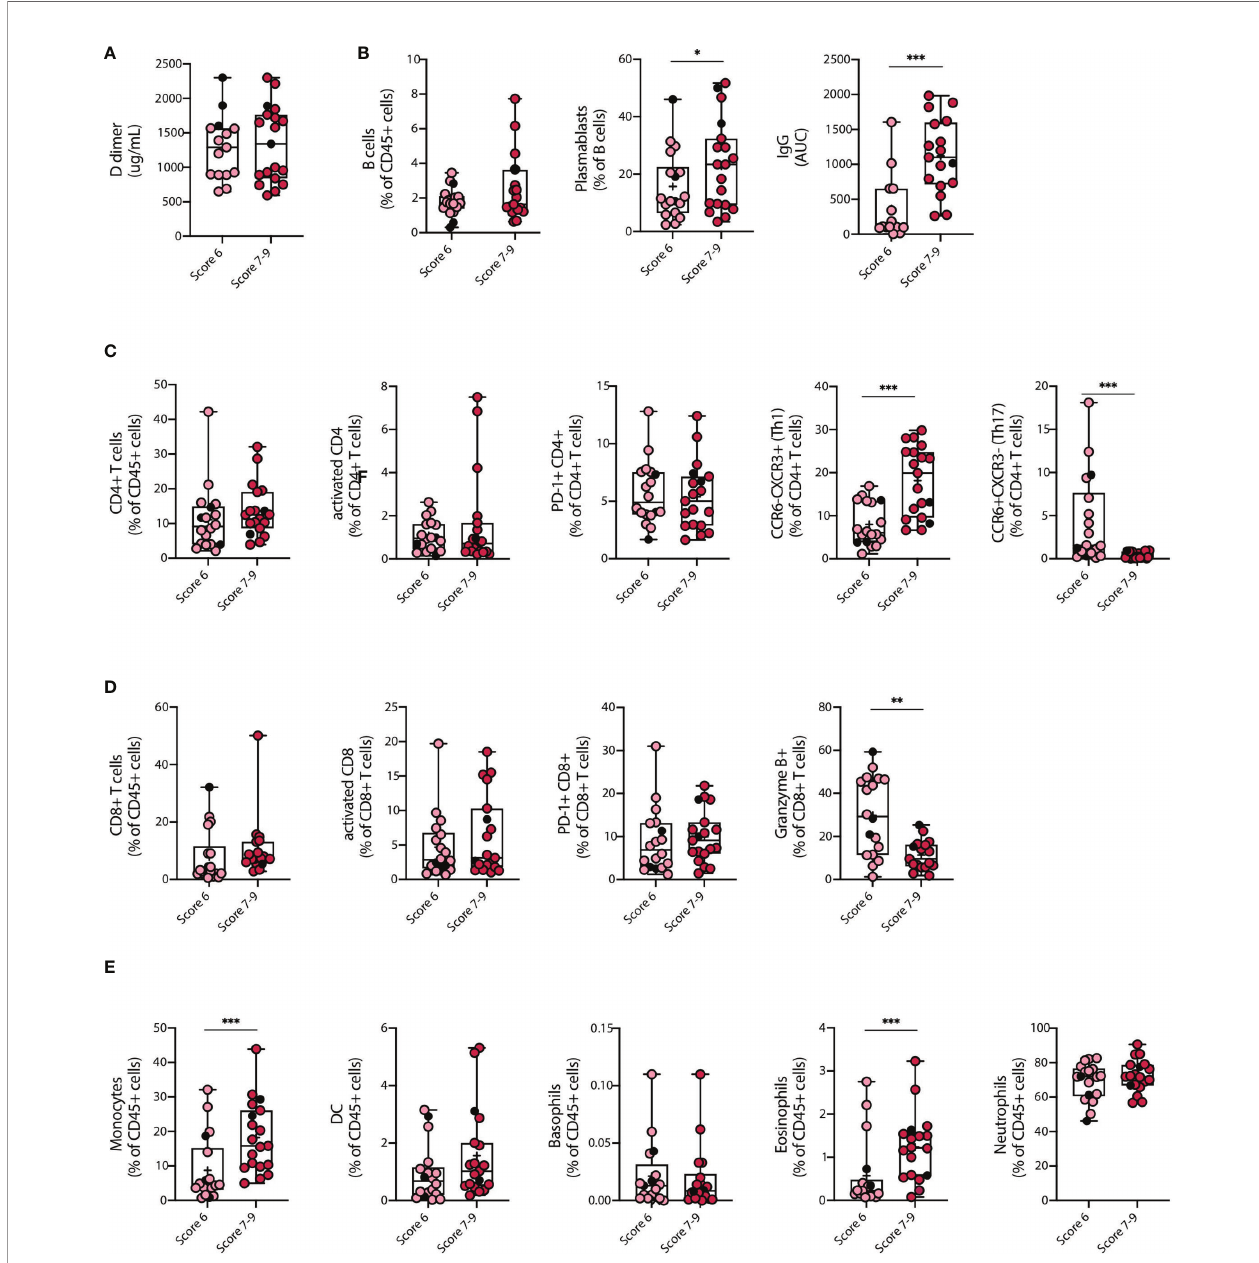
FIGURE 3 | Clinical parameters and differences in the immune cell landscape between Severe COVID-19 patients with different severity scores. Changes among key clinical parameters and main immune cell populations in peripheral blood of COVID-19 patients with severe SARS-CoV-2 infection (COVID-S) were assessed within patients with different severity scores. (A) D-dimer plasma concentrations. (B) Humoral response of COVID-S patients with different severity scores. B cell frequency on CD45 + cells, plasmablasts percentage within the B cell population and Immunoglobulin G (IgG) concentration in plasma. (C, D) Cellular immune response in COVID-S patients with different severity scores. (C) CD4 + T cell frequency within the CD45 + compartment, activated and PD-1 + CD4 + T cell populations and Th1 equivalents percentage of CD4 + T cells. (D) CD8 + T cell frequency within the CD45 + compartment, activated and PD-1 + CD8 + T cell populations and granzyme B + CD8 + T cells. (E) Myeloid cell and granulocyte compartment analysis from peripheral blood of COVID-19 severe patients classi fi ed by disease score. Graphs show frequency of monocytes, dendritic cells (DC), basophils, eosinophils and neutrophils within CD45 + cells. Score 6 = 18; Score 7-9 = 19. Black circles indicate deceased patients. Differences between groups were calculated using Mann Whitney tests (*p = 0,05; **p = 0,01; ***p = 0,001). Data mean is shown by a + on each box